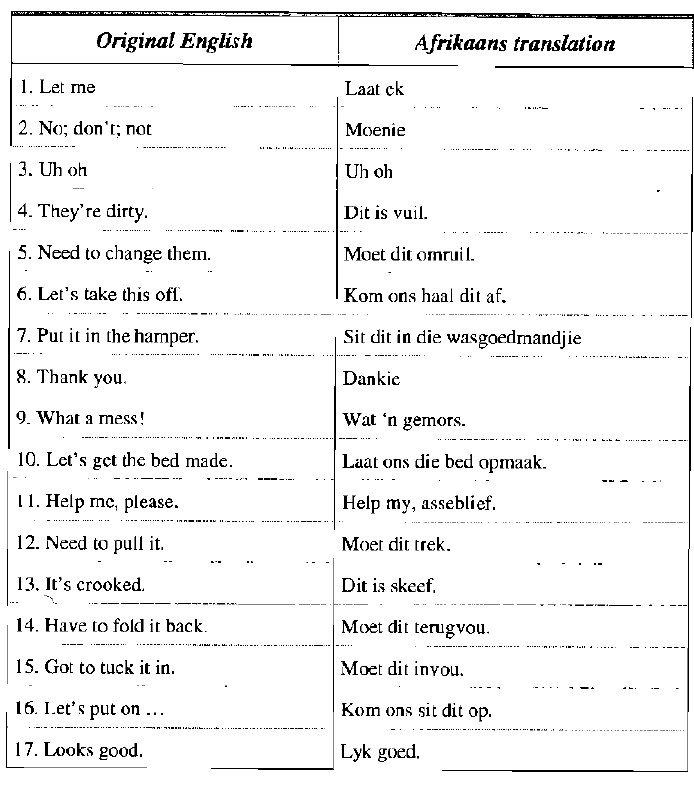
Table 1. Final translation of labels Original